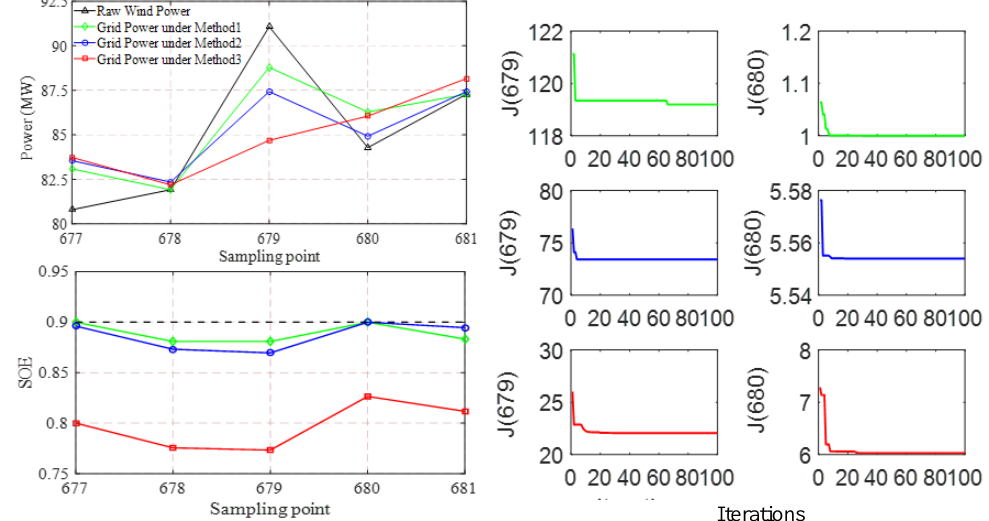
Figure 7. Grid-connected power and SOE at t = 677–681 with different methods and fitness function convergence curves at t = 679, 680 under the condition of Q = 2 MW, δ = 2.5 MW.